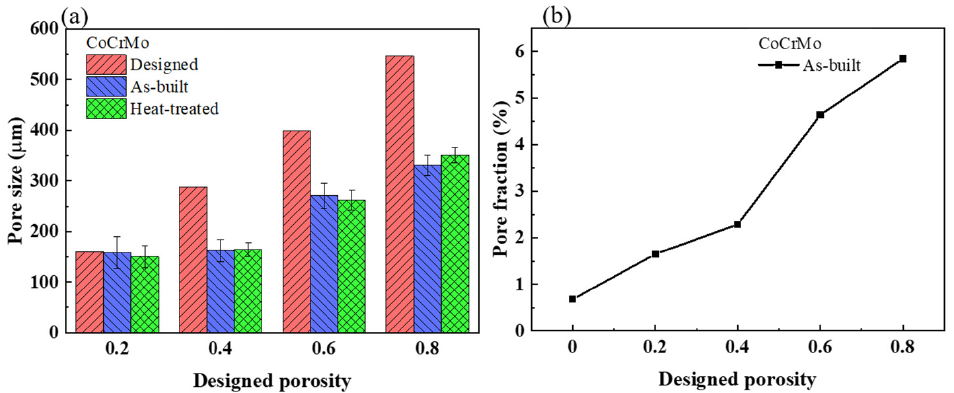
Figure 4. ( a ) Pore size in the designed, as-built, and heat-treated CoCrMo alloys with different, de- signed volume porosities. ( b ) Pore fraction in the as-built CoCrMo alloys with different, designed volume porosities.